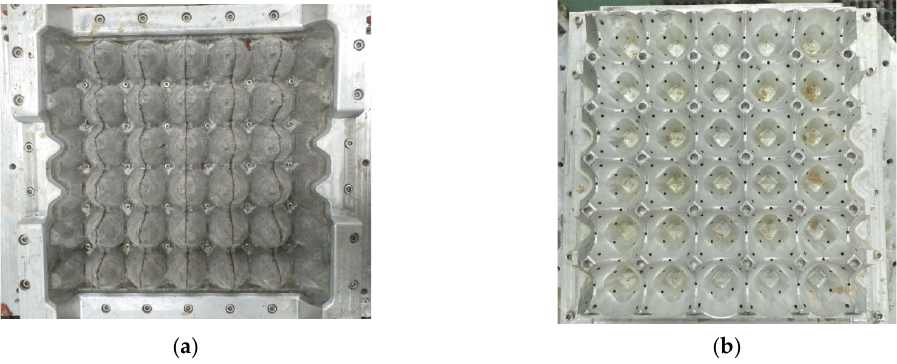
Figure 7. View of the sieve die ( a ) and view of the transfer die ( b ).